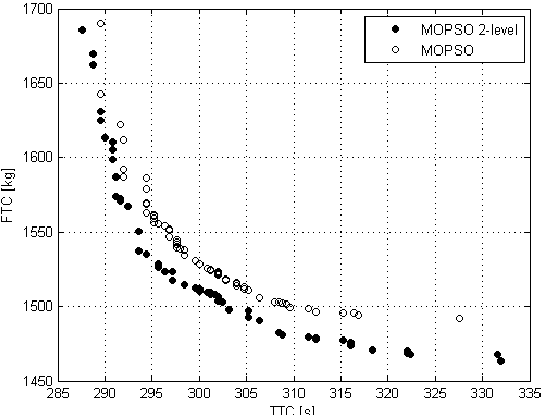
Figure 11. Pareto front produced by the proposed two-level MOPSO vs. standard MOPSO after 100 iterations, using a 20-particle population.